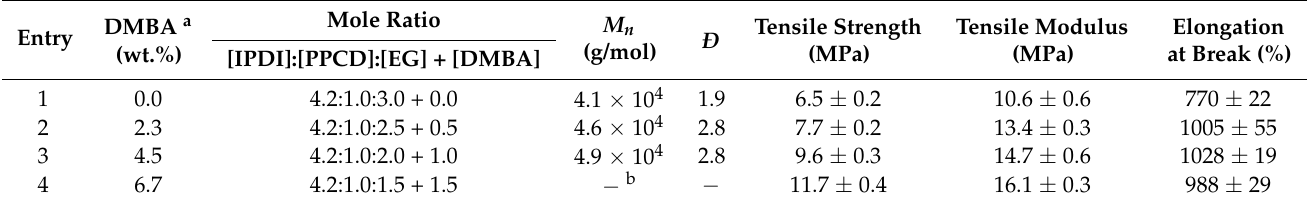
Table 1. Mechanical property and GPC data of TPU with different DMBA content.